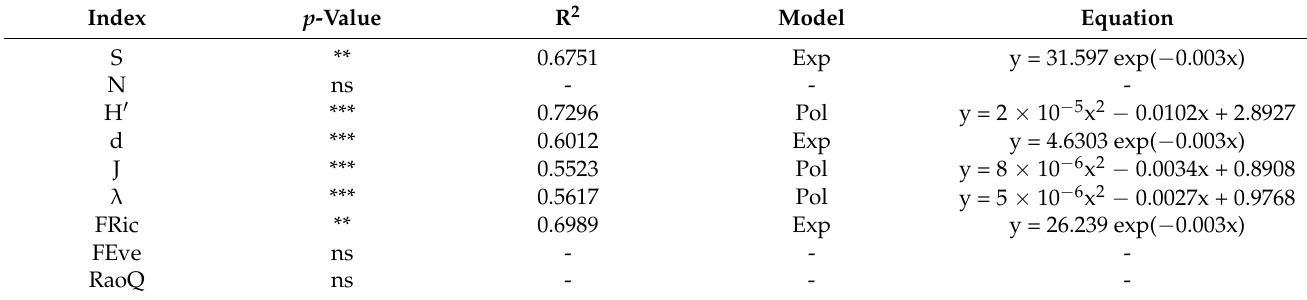
Table 4. Most fitted regression models between Distance from the source and the community index ( S—Species richness; N—Individuals abundance; H ′ —Shannon–Wienner Index; d—Margalef Index; J—Pielou Index; λ —Simpson Index; FRic—Functional Richness; FEve—Functional Evenness; RaoQ—Rao Quadratic Entropy ) ( Exp—exponential; Pol—Poly- nomial ).